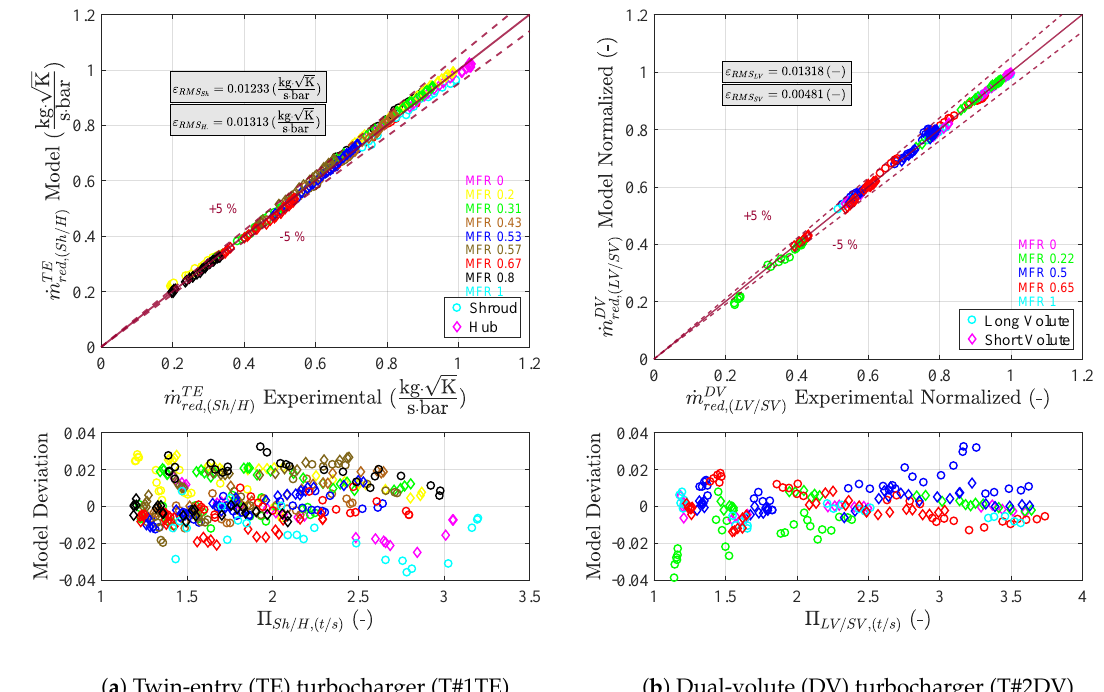
Figure 13. Reduced mass flow Modeled versus Experimental for T#1TE and T#2DV turbochargers using the global fitting constants shown in Table